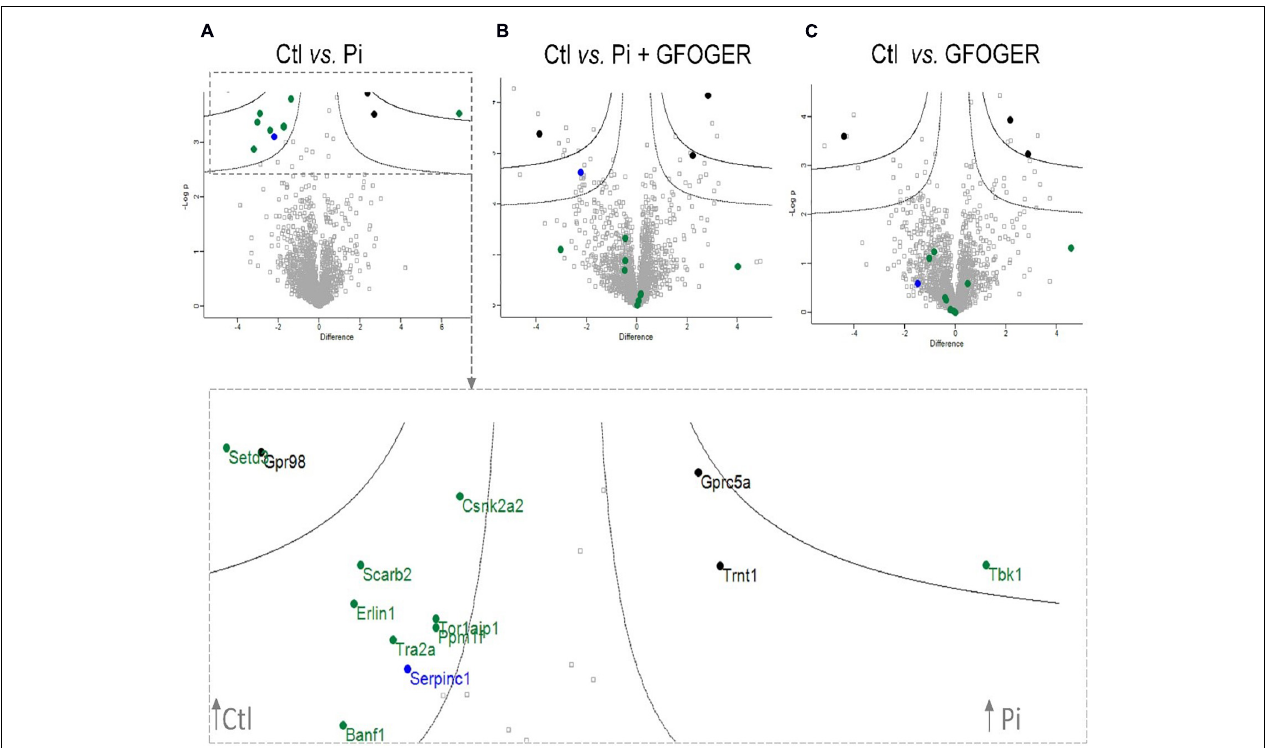
FIGURE 4 | Volcano plots indicating significant GFOGER effects on expression of EVs’ proteins. EVs were prepared from MOVAS-1 cells’ culture media after a 10-day treatment with 4 mM Pi in the presence or absence of 500 µ M GFOGER peptide. EVs were prepared from culture media of three independent experiments. Log-transformed p -values associated with individual protein against log-transformed fold change in abundance between (A) control vs. 4 mM Pi conditions, (B) control vs. Pi + GFOGER conditions, and (C) control vs. GFOGER conditions. Green: proteins altered after Pi and rescued by GFOGER; black: proteins non-specifically altered after Pi; blue: proteins altered after Pi and not rescued by